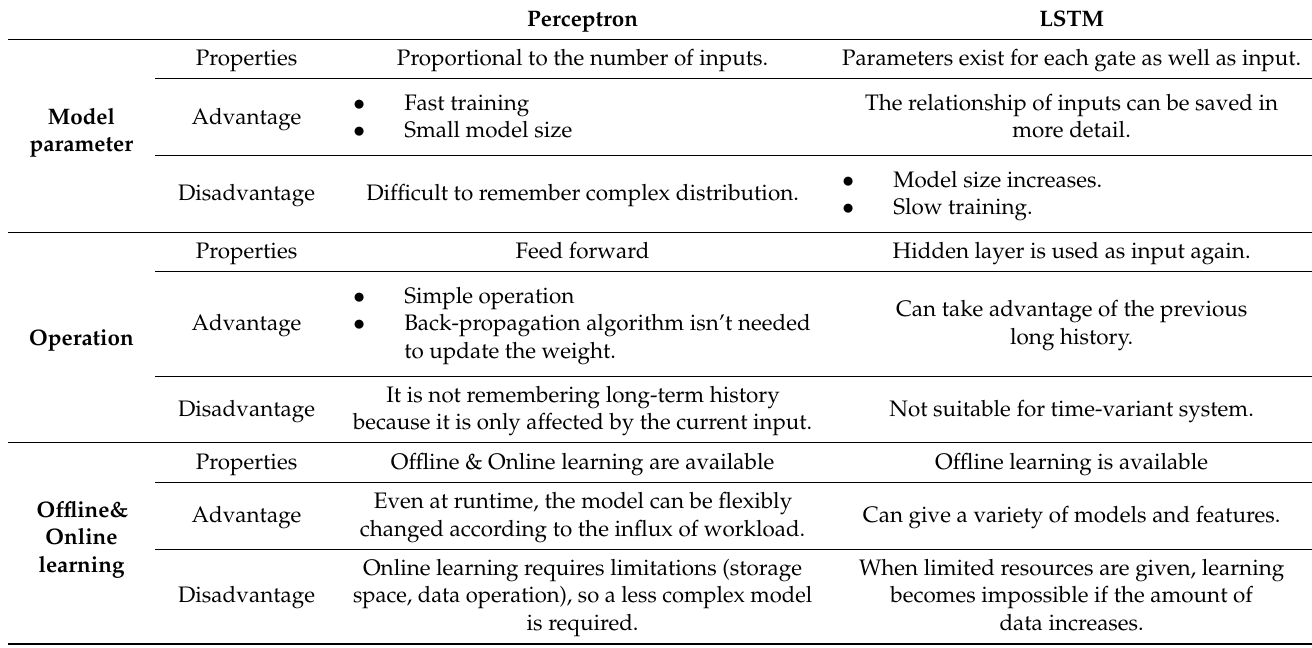
Table 3. Properties and Advantages and Disadvantages of Perceptron and